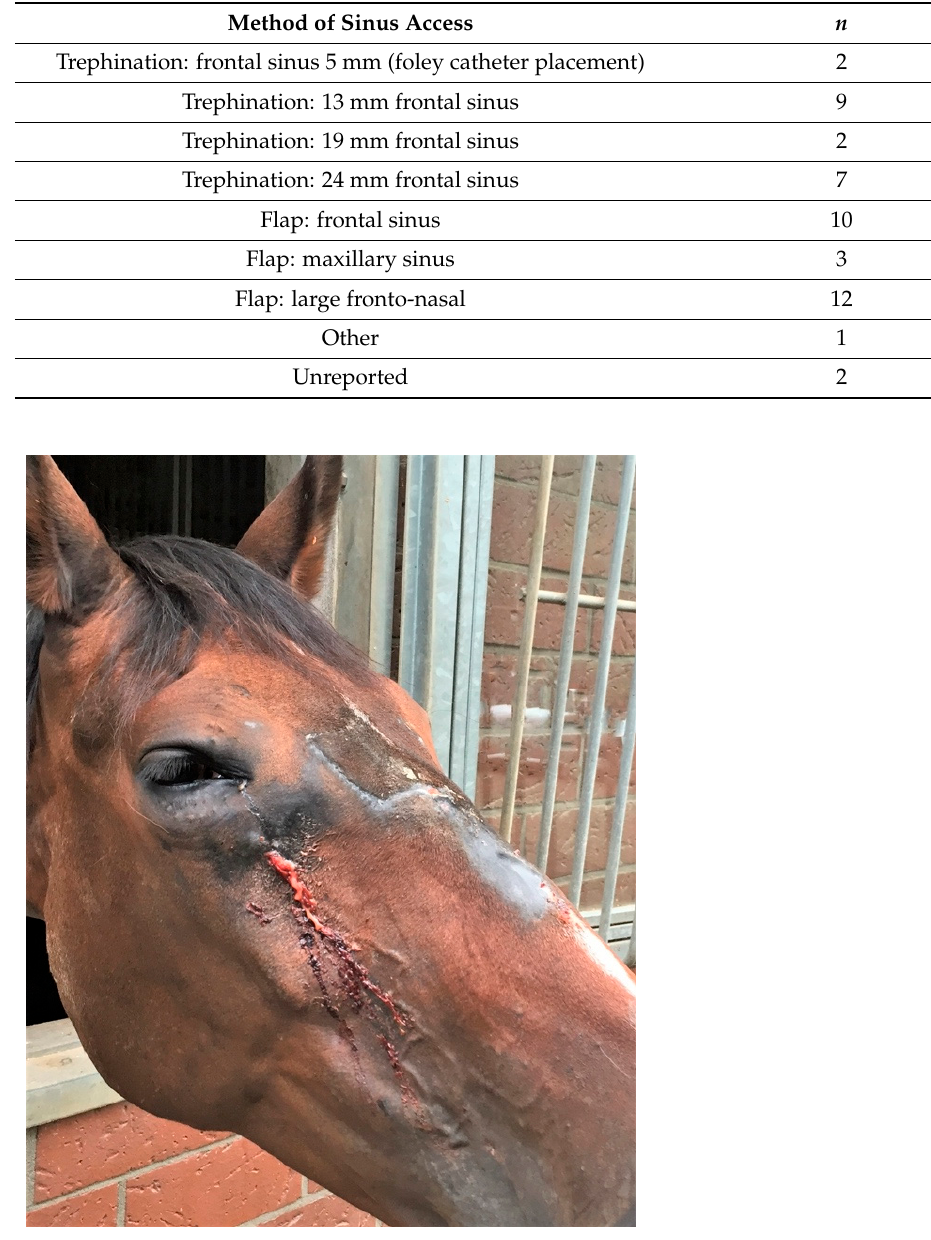
Table 5. Method of surgical access to the sinus in 48 cases of equine suture exostosis developed after sinus surgery.